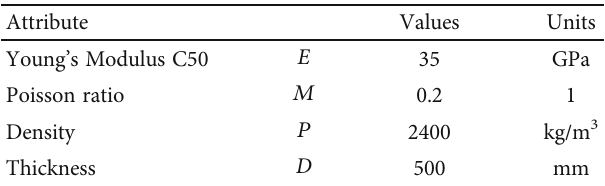
Table 2: Shaft wall parameters.